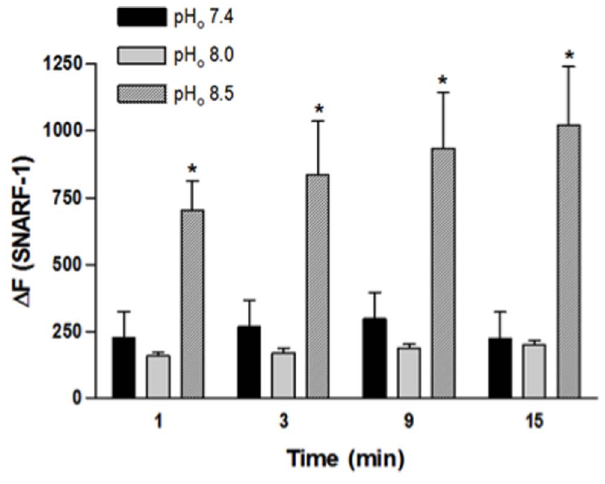
Figure 1. Effect of extracellular alkalinization on pH i in isolated endothelial cells from rat aorta. Cells were loaded with SNARF-1 (10 m M) and analyzed by flow cytometry. NaOH was used to increase pH o from 7.4 to 8.0 and from 7.4 to 8.5; Hanks solution pH 7.4 served as control. Fluorescence intensity was measured before the NaOH stimulus (F 0 ) and at different time points (t=1, 3, 9 and 15 min) after this stimulus (F t ). Results are reported as D F=F t - F 0 . All values are means 6 SEM (n=7). Two-way ANOVA, Bonferroni’s post-test, * p , 0.05 versus